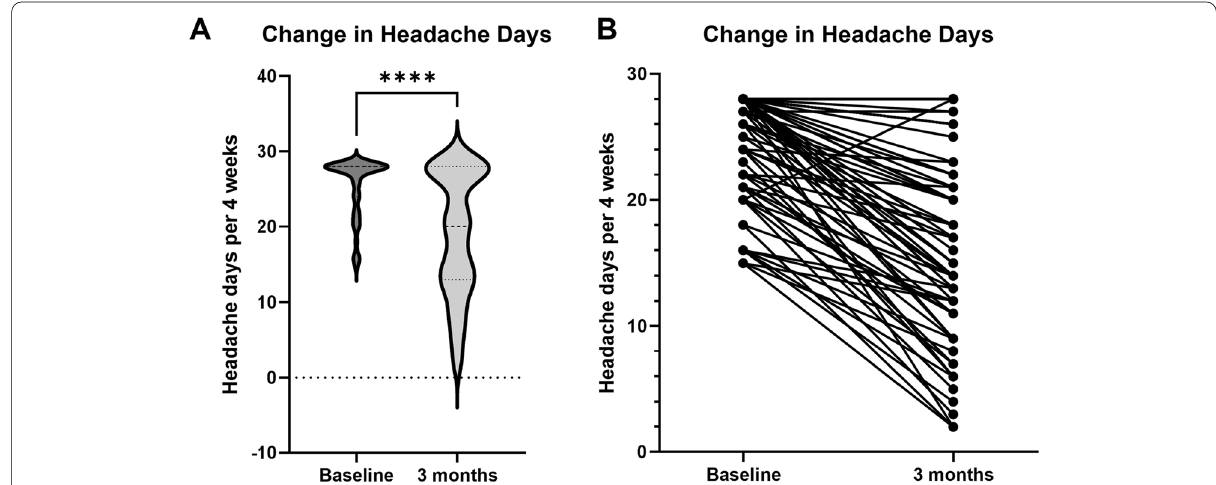
Fig. 1 violin plot (a) and before-after individual values plot (b) showing headache days at 3 months compared to baseline. There was a significant reduction in headache days. In (a) dashed line shows median, dotted lines at upper and lower quartiles. **** p < 0.0001 by Wilcoxon